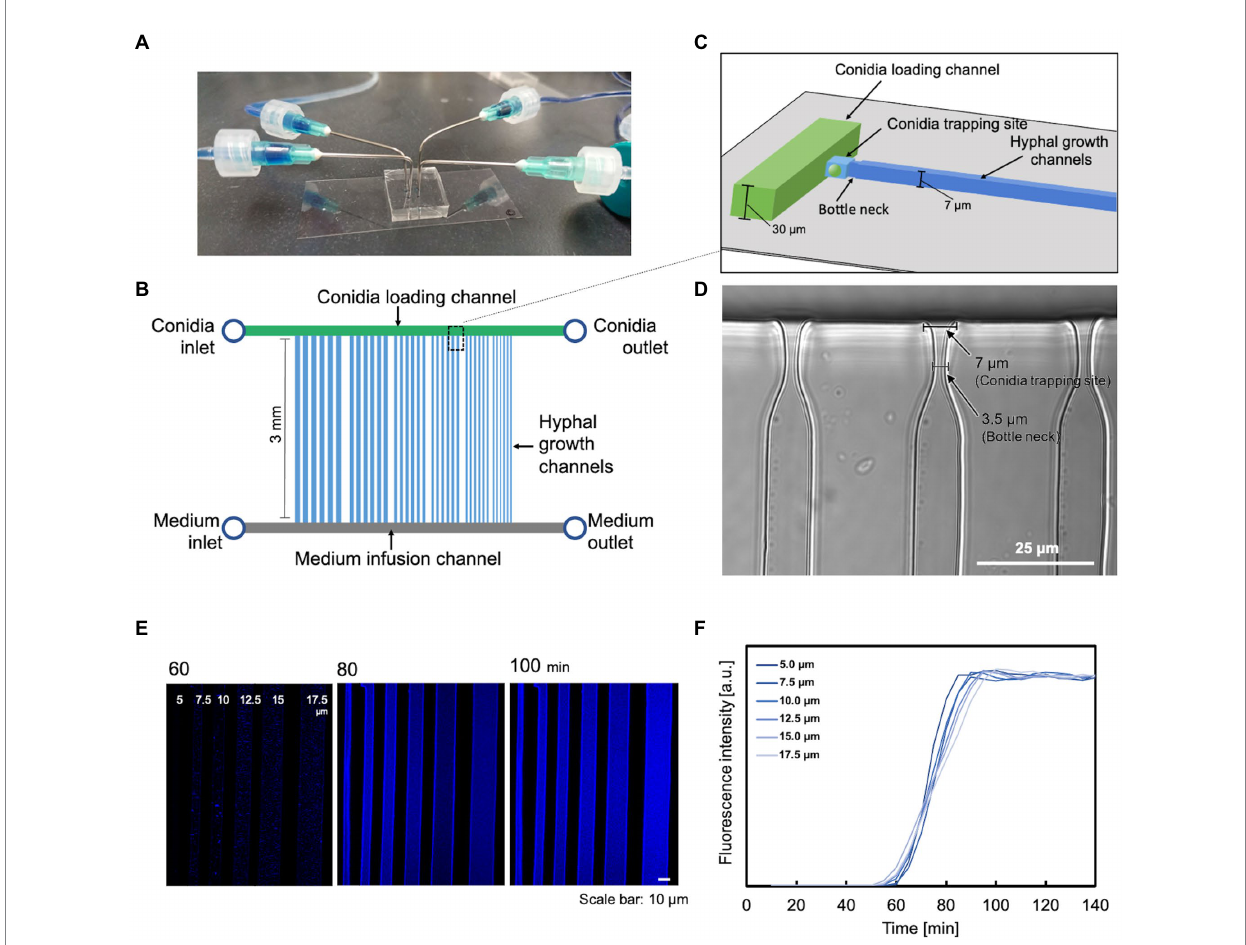
FIGURE 1 A microfluidic device for analyzing the growth and dynamics of a hypha. (A) External view of the microfluidic device. (B) Schematic representation of the chip layout: it consists of two inlets for supplying cells and medium, respectively, two outlets, a parallel array of conidia supply channels (green), medium injection channels (gray), and hypha growth channels (blue). (C) Schematic representation of the conidia trapping site containing two short channels of different dimensions (light blue) connecting the conidia supply channel (green) and the hypha growth channel (blue). The narrower and shallower channel traps a single conidium. (D) Image of the constricted structure for conidia trapping. Scale bar: 25 μ m. (E,F) Molecular diffusion properties on microdevices with different channel widths. (E) Visualization of the gradient profile. Scale bar: 10 μ m. (F) Quantification of the gradient profile of CFW diffusion to steady state. The measurements were carried out in the middle of the channel, just below the spore trap